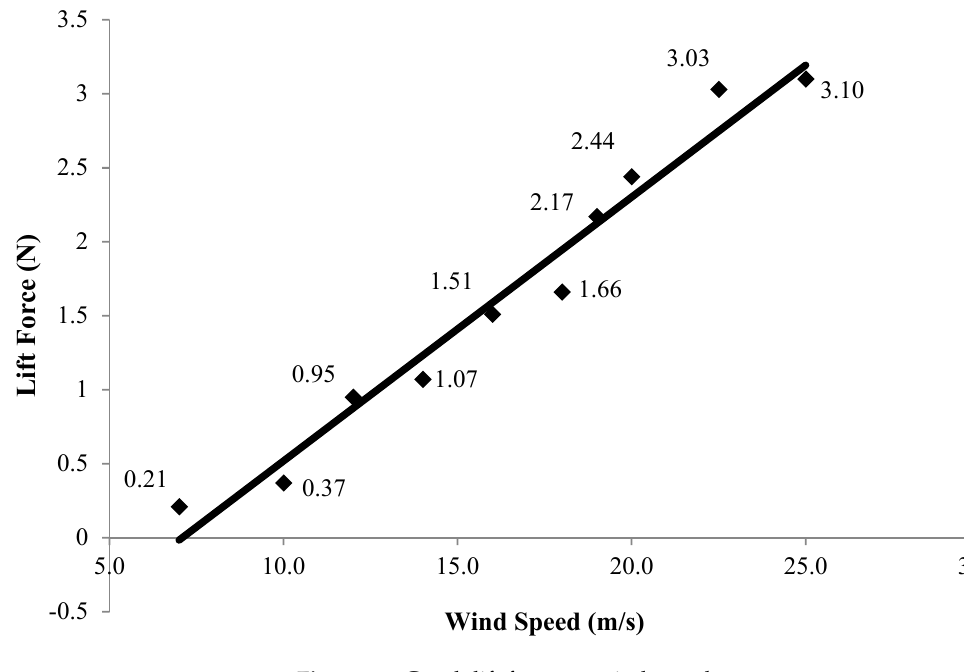
Figure 15. Graph lift force vs. wind speed.